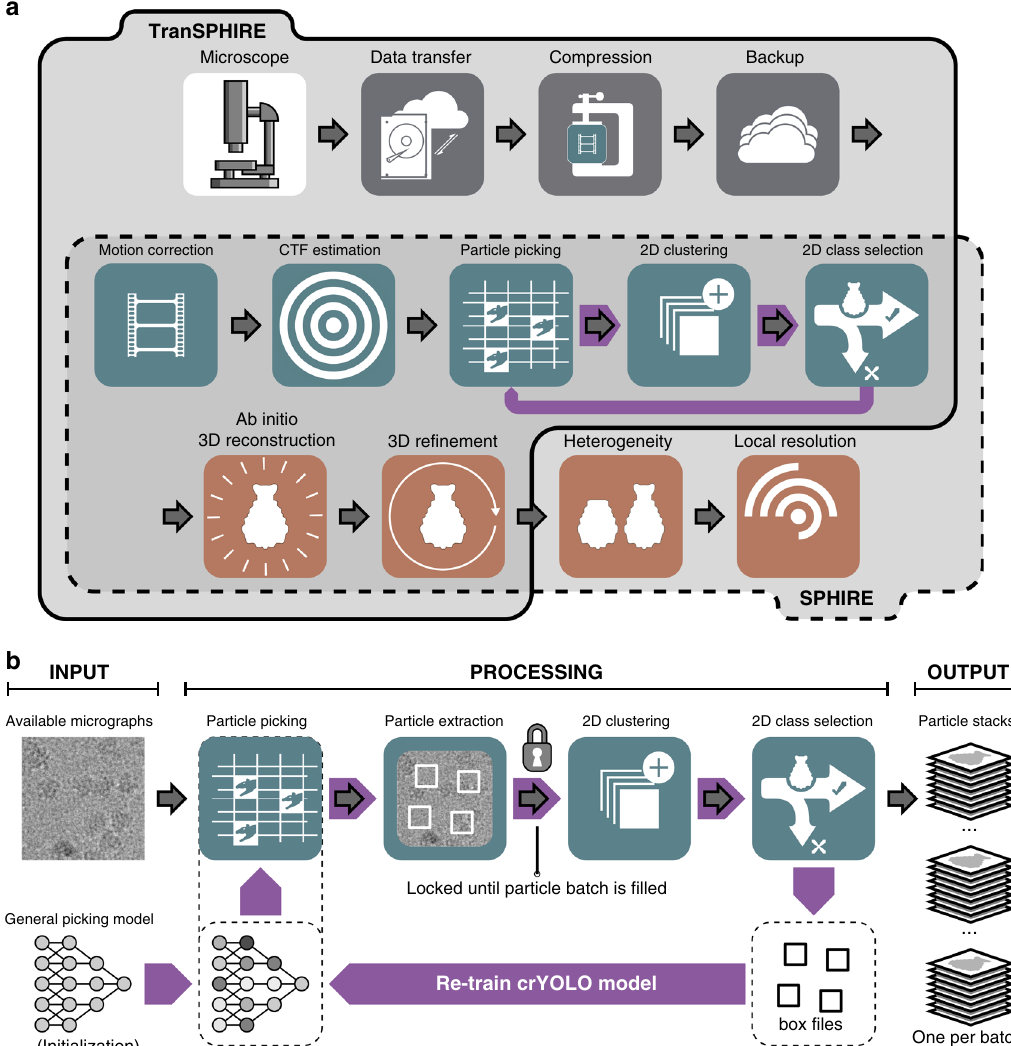
Fig. 1 The TranSPHIRE pipeline and the SPHIRE backend. a Upper register (solid line): Overview of the integrated TranSPHIRE pipeline and all automated processing steps. The pipeline includes fi le management tasks, i.e., parallelized data transfer, fi le compression, and fi le backup (gray); 2D processing, i.e., motion correction, CTF estimation, particle picking, 2D clustering, and 2D class selection (turquoise); and 3D processing, i.e., ab initio 3D